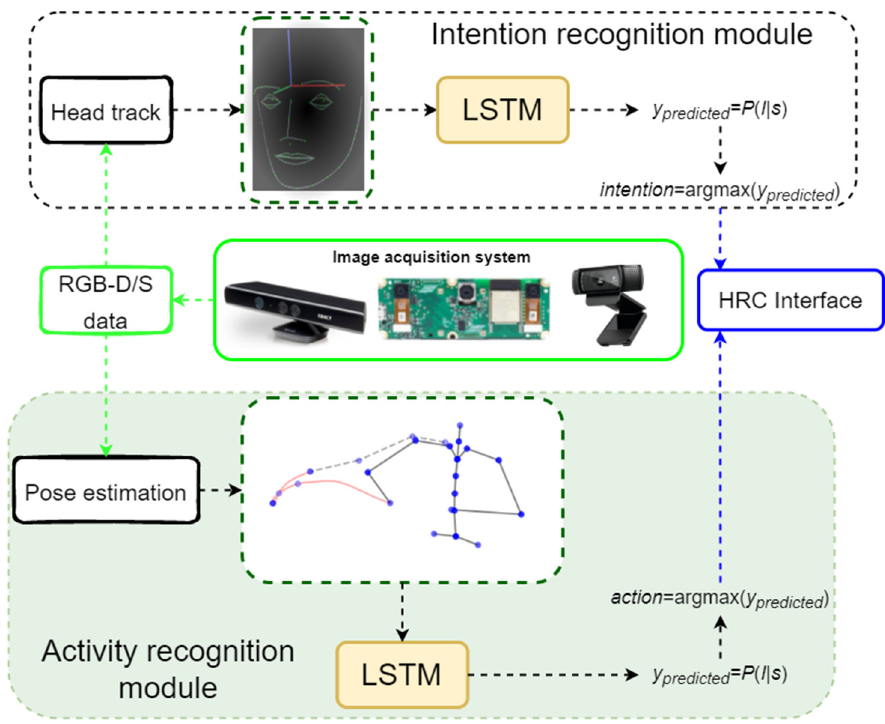
Figure 1. Safe HRC framework, based on human activity recognition and pose prediction.